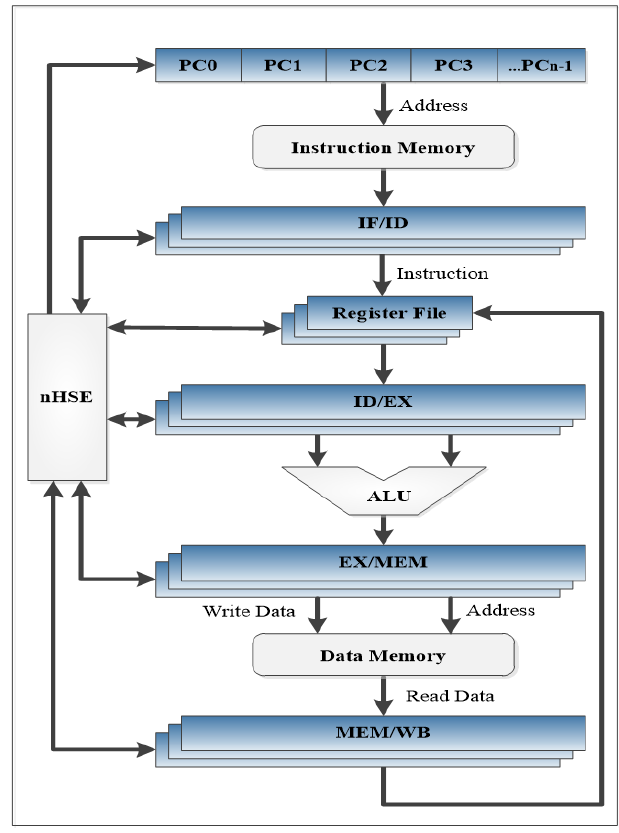
Fig. 4. nMPRA CPU